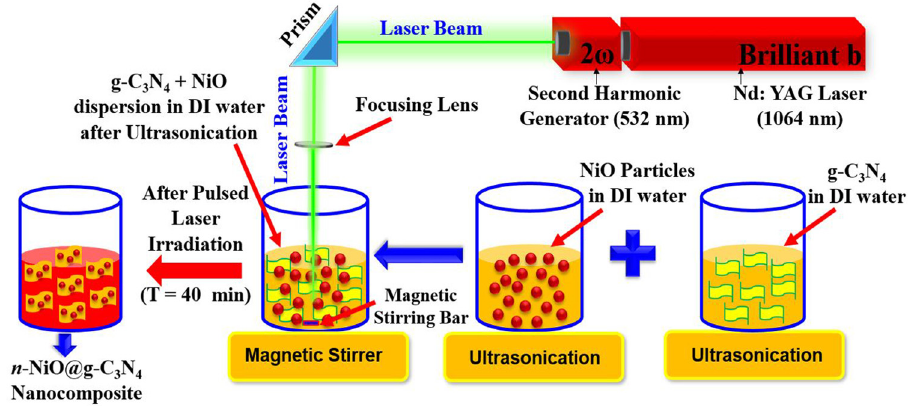
Figure 1: Schematic diagram for the synthesis of n - NiO@g - C 3 N 4 nanocomposites by pulsed laser fragmentation and pulse laser - assisted